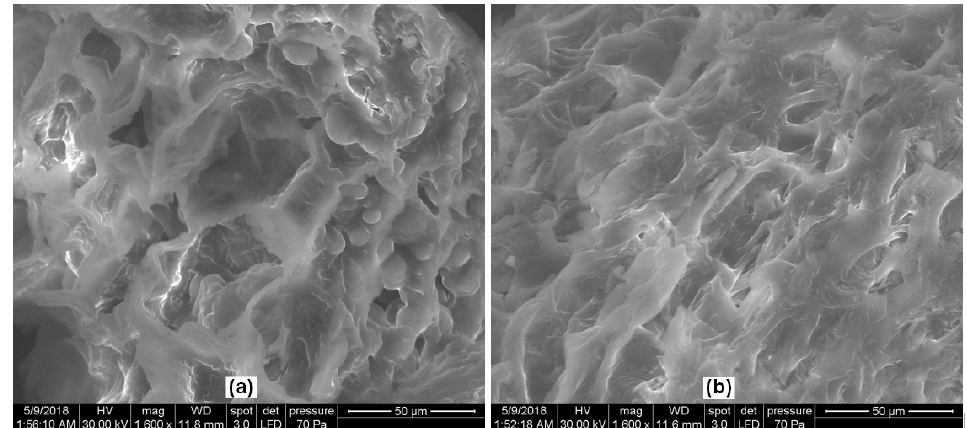
Figure 1. Scanning electron microscopy images of DBPH powder: ( a ) before and ( b ) after MB adsorption.